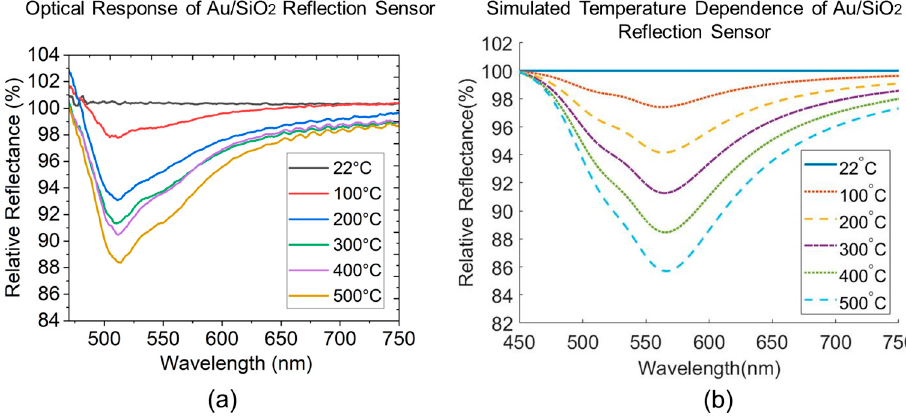
Figure 11. ( a ) Experimental results of the optical response of an Au/SiO 2 plasmonic reflection sensor under temperature sensing test. ( b ) Simulated optical response to temperature of the same using the optical waveguide model.